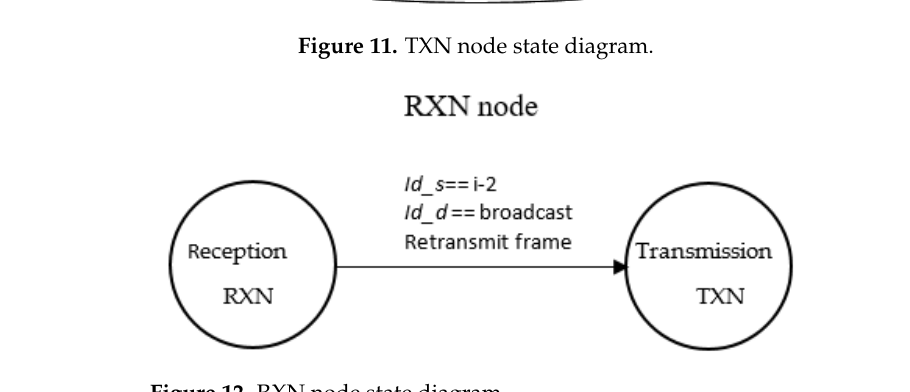
Figure 12. RXN node state diagram.